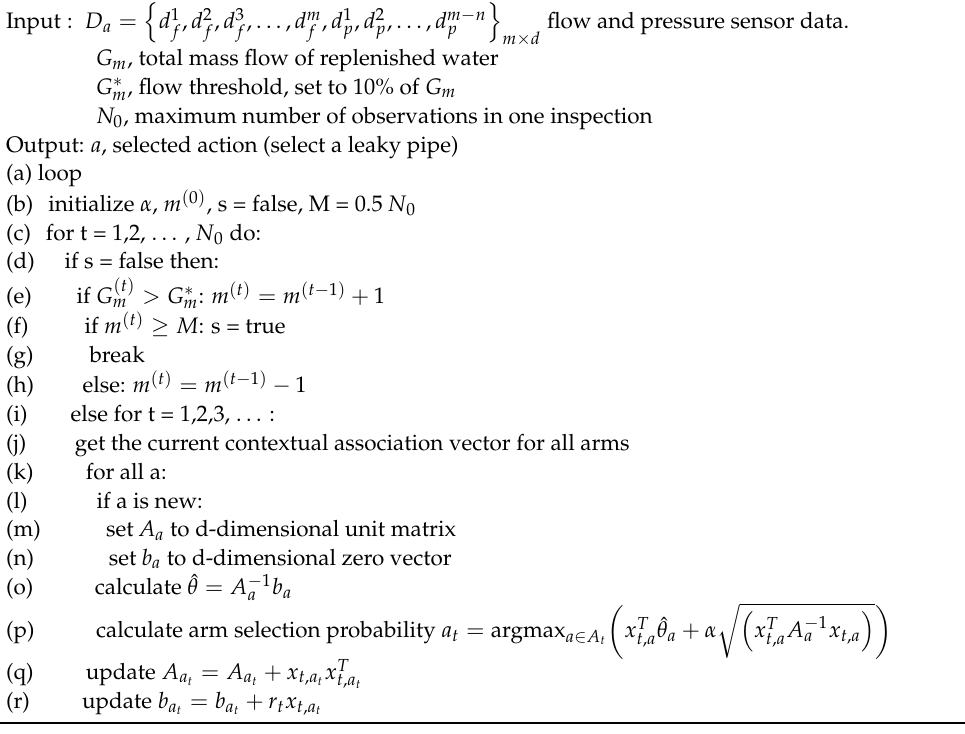
Algorithm 1. Leakage fault detection algorithm based on Contextual Bandit